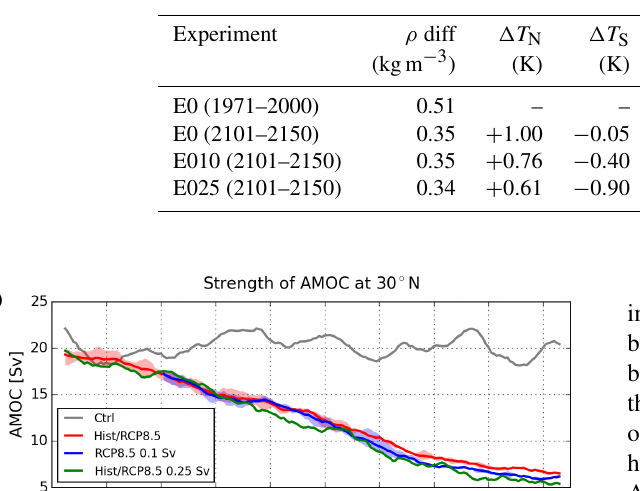
Table 2. Annual mean meridional density difference ( ρ diff) in the NE Atlantic (45–62 ◦ N, 15–28 ◦ W) averaged over 500–1000m depth as well as changes (2101–2150 minus 1971–2000) in temperature ( T ), salinity ( S ) and density ( ρ ) in the north (subscript N) and south (subscript S) of the given NE Atlantic region. Ensemble spread for E0 and E010 is about ± 10%.